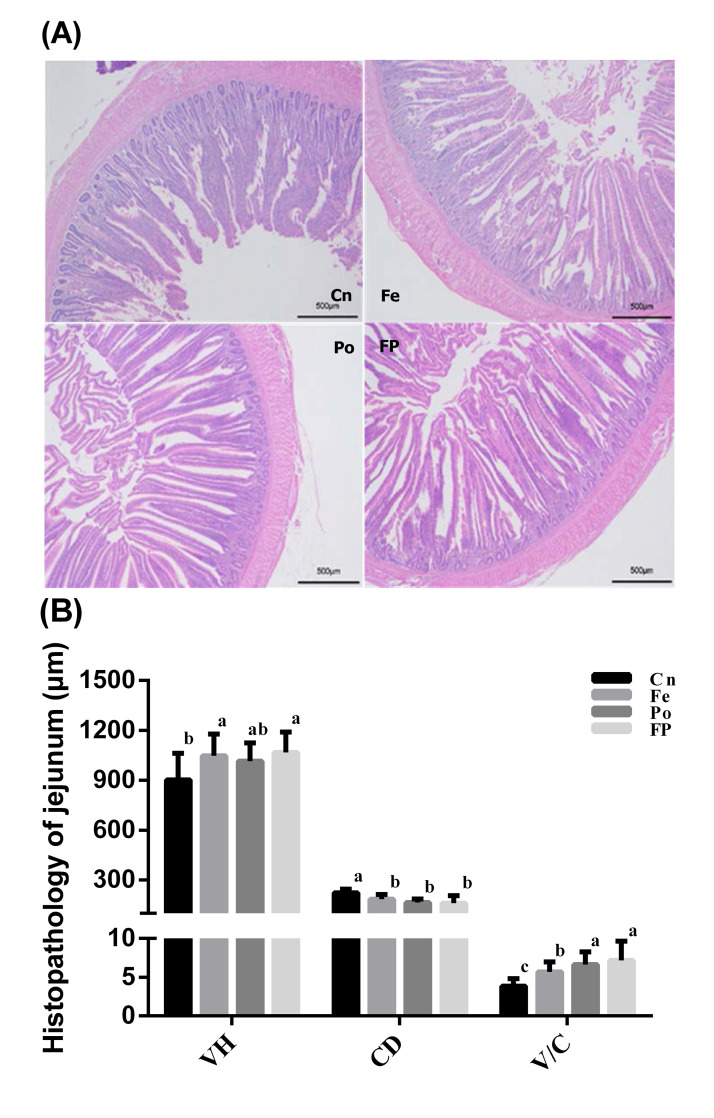
Effects of dietary treatment on villus height, crypt depth, and the ratio of villus height to crypt depth in the jejunum of broiler chickens.Treatments with different letters are significantly different at P < 0.05. Data were obtained from transmission electron microscopy, and were means of 10 birds (2 bird from each pen). Cn, 100% complete feed group; Fe, 100% microbial fermented feed group; Po, 100% complete feed and ginseng polysaccharide group; FP, 100% microbial fermented feed and ginseng polysaccharide group. VH, villus height; CD, crypt depth; V/C, the ratio of villus height to crypt depth.